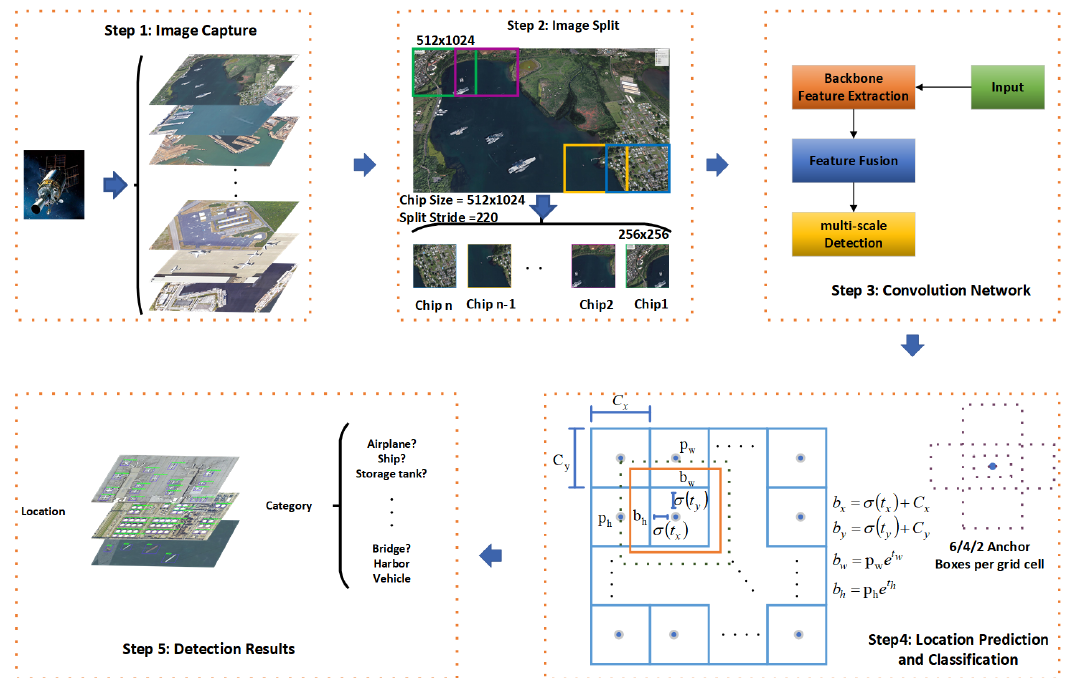
Figure 1. Onboard detection process. First, capture images by an onboard camera. Second, split large size image into small chips. Third, feature extraction. Fourth, location regression and classification. Fifth, get detection results.